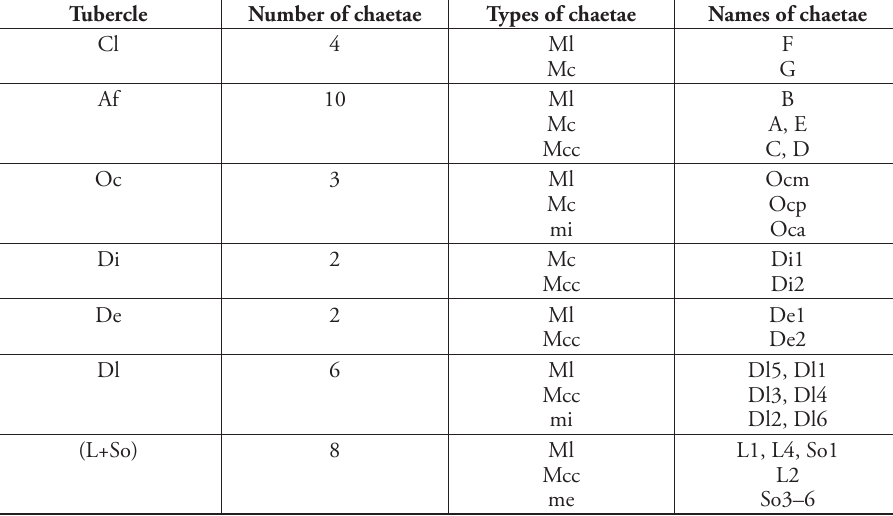
Table 3a. Chaetotaxy of Endonura turkmenica sp. n.: cephalic chaetotaxy dorsal side. Tubercle